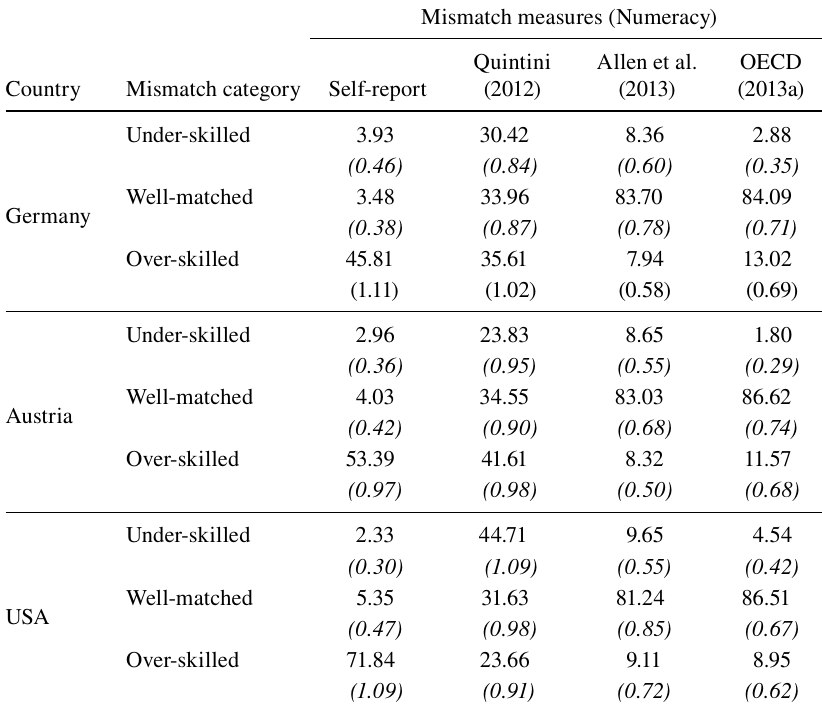
Table 3 Share of mismatched workers by definition of skill mismatch